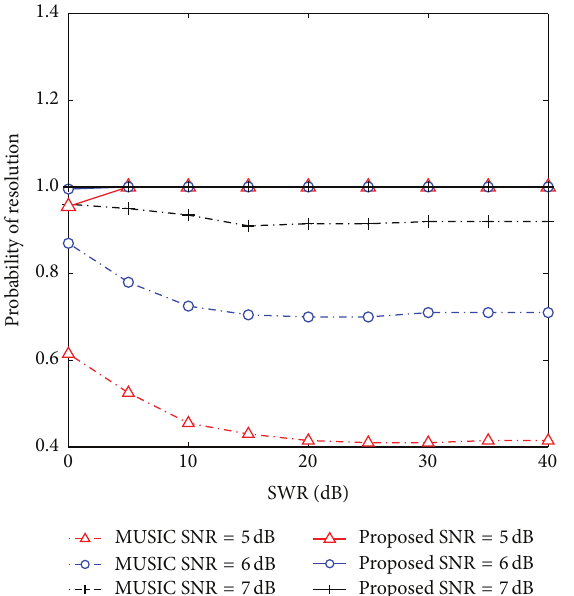
also shows a higher resolution probability for sources with identical powers, as illustrated by SWR = 0